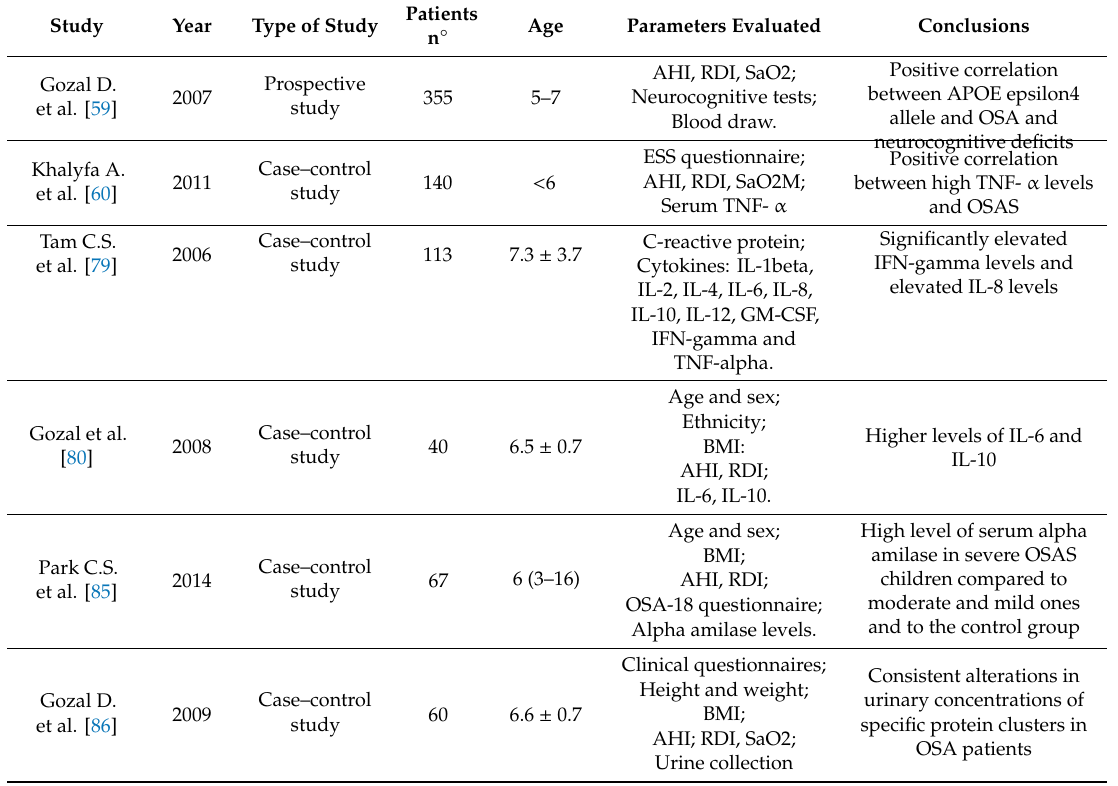
Table 6. Studies that have analyzed inflammatory factors and biomarkers as pediatric OSAS risk